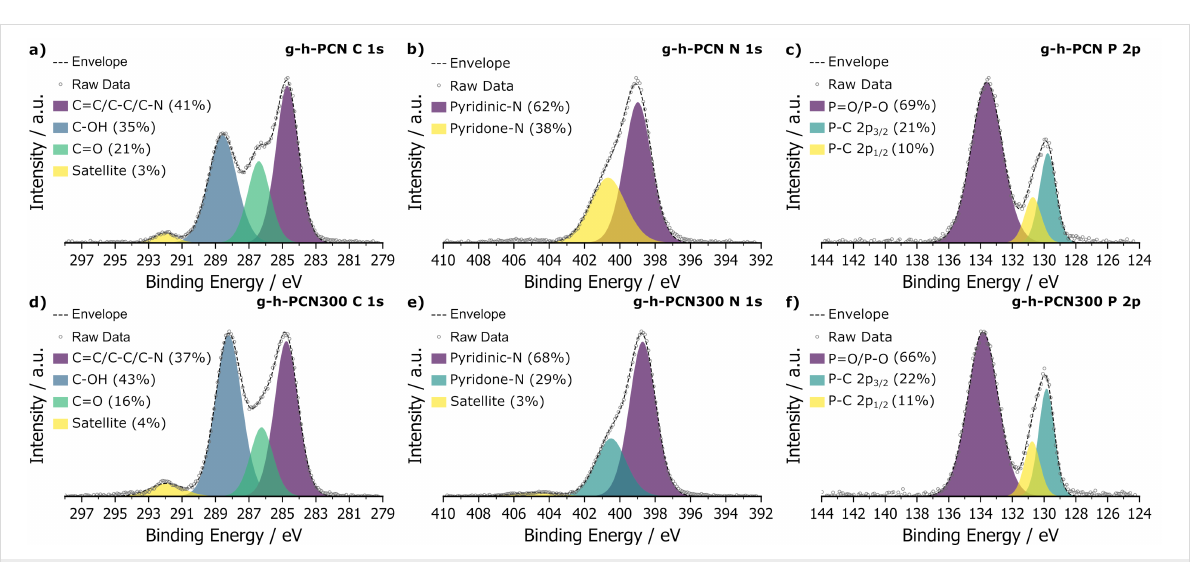
Figure 1: PXRD patterns of g-h-PCN (green) and g-h-PCN300 (teal).